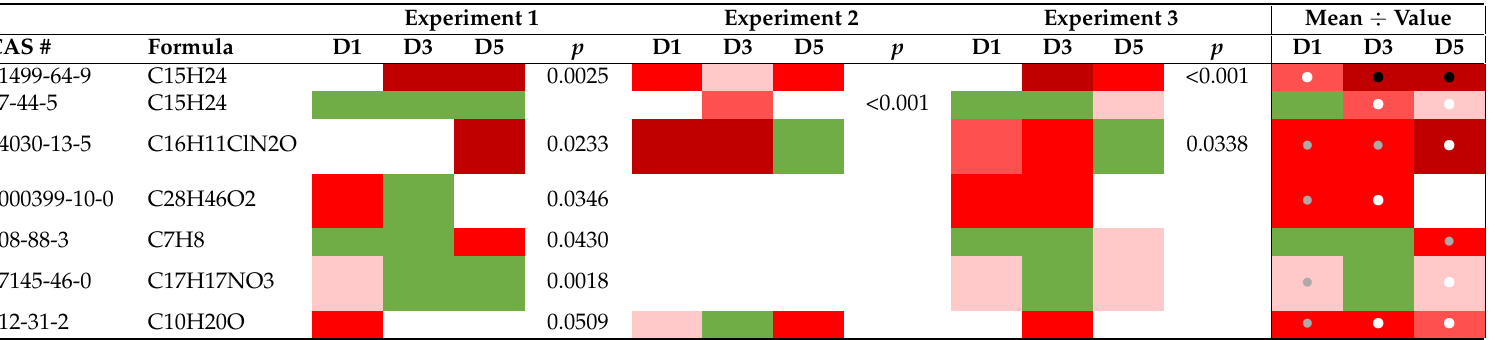
Table 1. Bastid ® -induced VOCs: VOCs analysed by SBSE-GC-MS were selected when significant ( p < 0.05) and induced (FC > 1.5) at least twice in three separate experiments, compared to the water control. Coloured boxes, Bastid ® / H 2 O induction ratios 1, 3, and 5 days post treatment (on D1, D3 and D5), with (cid:4) fold change (FC) < 1.5 (not induced); (cid:4) 1.5–10 2 ; (cid:4) 10 2 –10 3